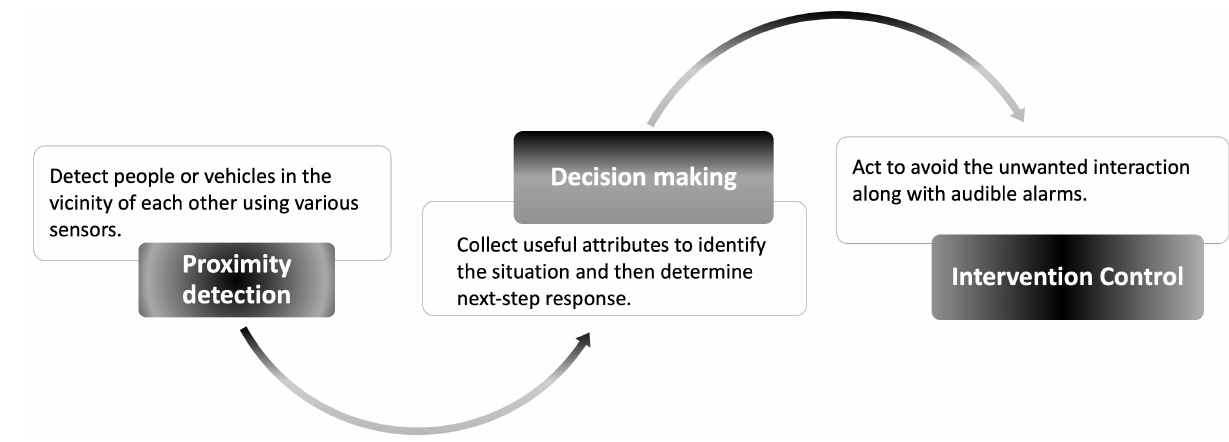
Figure 1. The working flow diagram of a typical